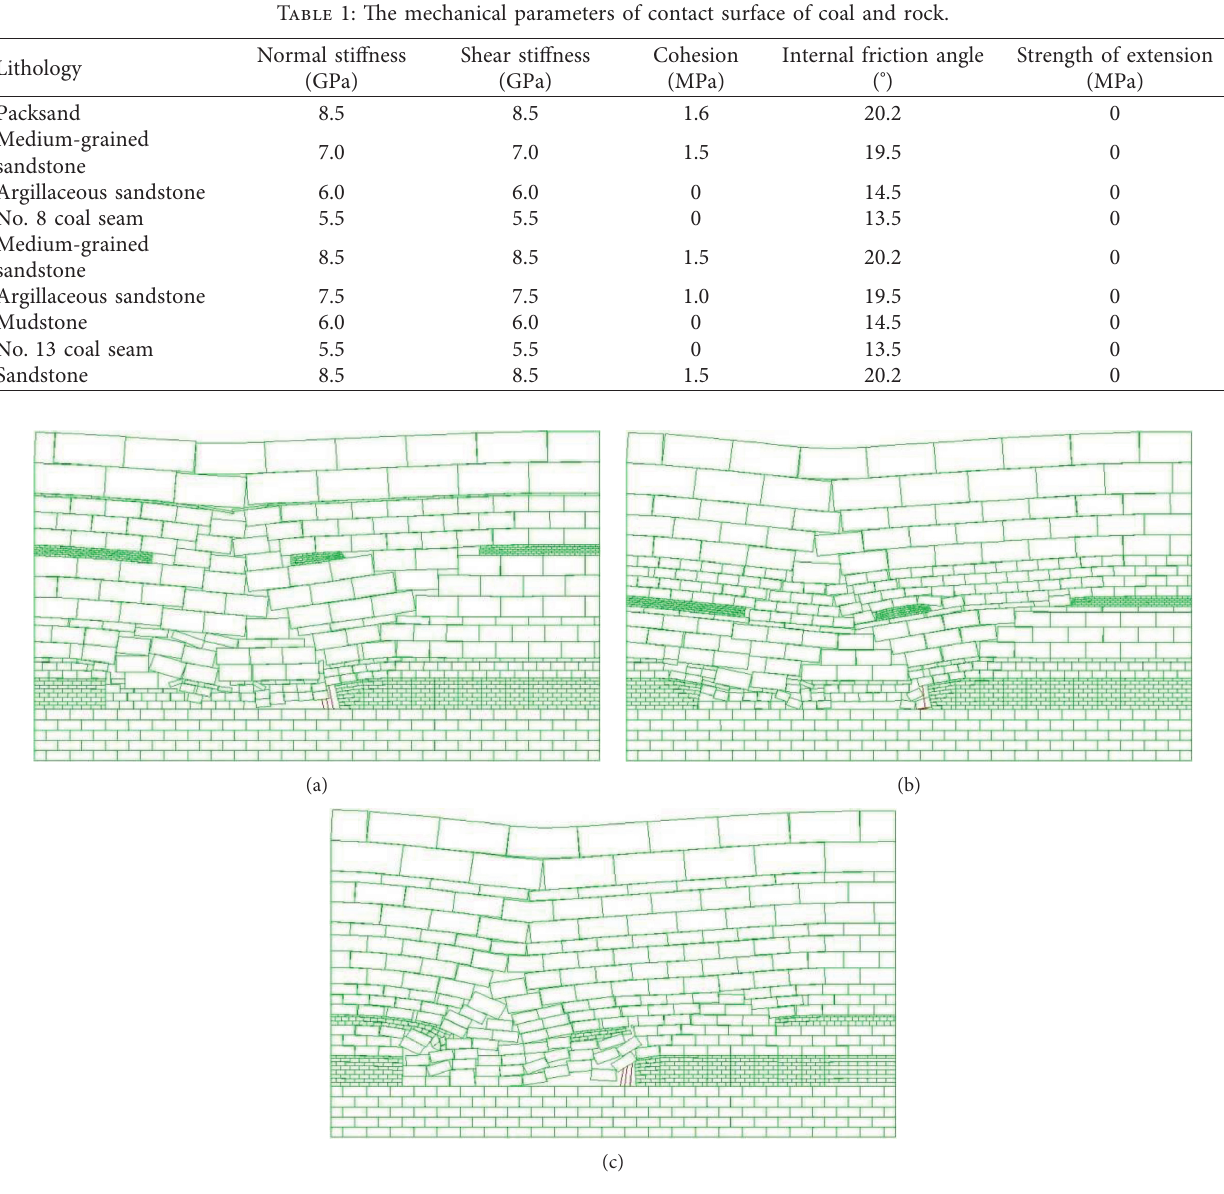
Figure 2: The characteristics of rock collapse with different interlayer thickness when the working face advances 100 m. (a) Thickness of